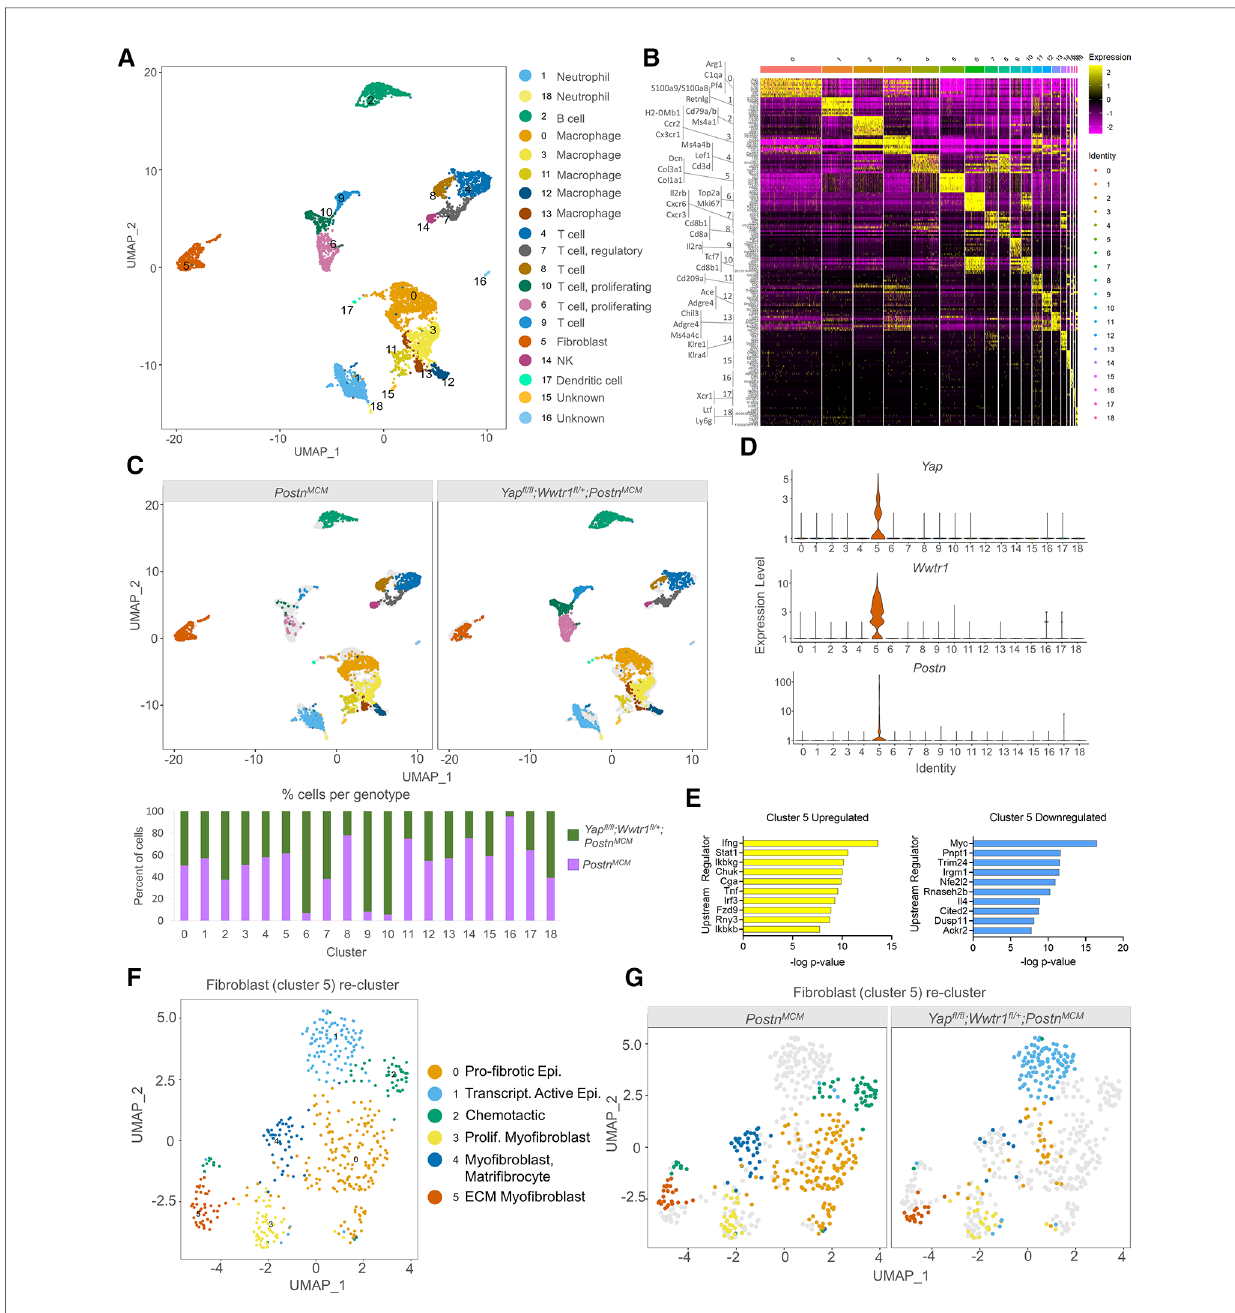
FIGURE 4 scRNAseq reveals Yap and Wwtr1 downstream targets in cardiac fi broblasts post MI. ( A ) UMAP projection and identi fi cation of combined interstitial cardiac cells, post fi ltering, from Postn MCM and Yap fl / fl ;Wwtr1 fl /+ ;Postn MCM adult mouse heart 7 dpi. Clusters are identi fi ed by enriched gene markers in Supplementary Table S4 . ( B ) Heatmap of top 10 genes enriched within each cluster. ( C ) UMAP projection split by genotype and quanti fi cation of percent of cells from each genotype for each cell cluster. ( D ) Violin plots denoting UMI count for Yap , Wwtr1 , or Postn for each cluster. ( E ) IPA analysis of predicted upstream regulators of upregulated or downregulated DEGs (Y ap fl / fl ;Wwtr1 fl /+ ;Postn MCM vs. Postn MCM ) in fi broblasts (cluster 5). ( F ) UMAP projection of re-clustering only fi broblasts (cluster 5) and identi fi cation of cardiac fi broblast subclusters. Epi., epicardial; Trascript., transcriptionally; Prolif., Proliferating; Myo fi b., myo fi broblast; MFC, matri fi bocyte. ( G ) UMAP projection split by